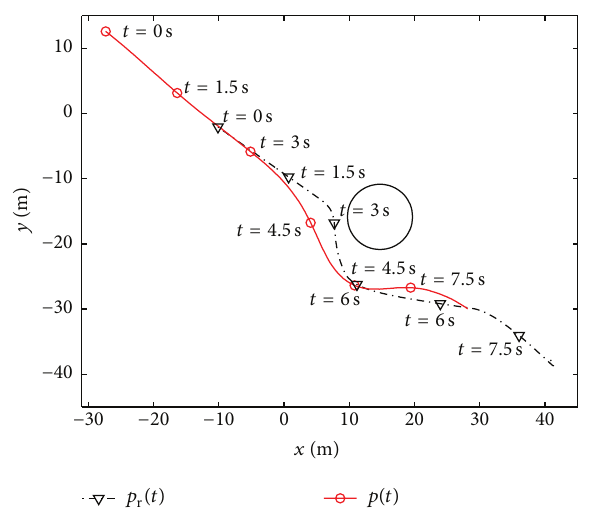
Figure 21: Obstacle avoidance at high speeds. Triangles and circles denote the location of reference system and vehicle, respectively, at certain instances in